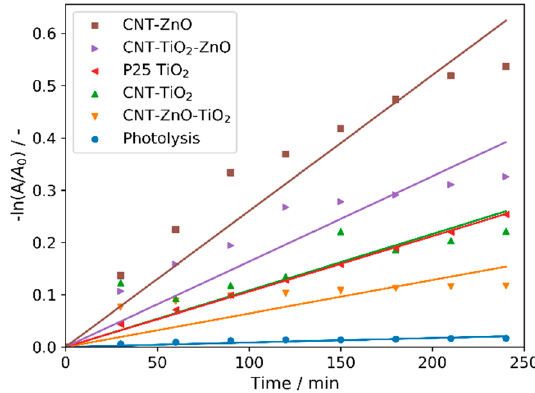
Figure 7. Pseudo first order linear fitting of the photocatalysis. Table 5. Results of the photocatalytic experiments.